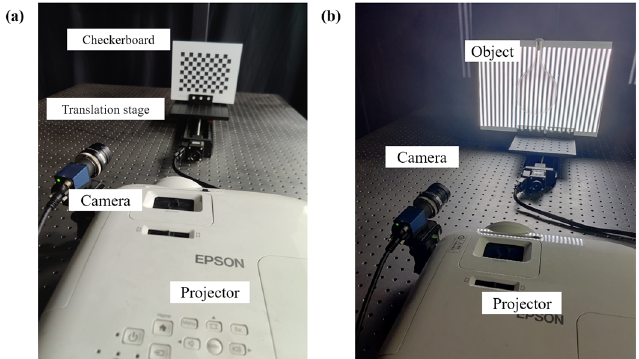
Figure 12. Experimental measurement system. ( a ) Calibration scheme. ( b ) Measurement scheme.